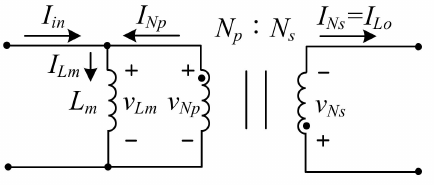
Figure 12. Equivalent model for DC current analysis of the coupled